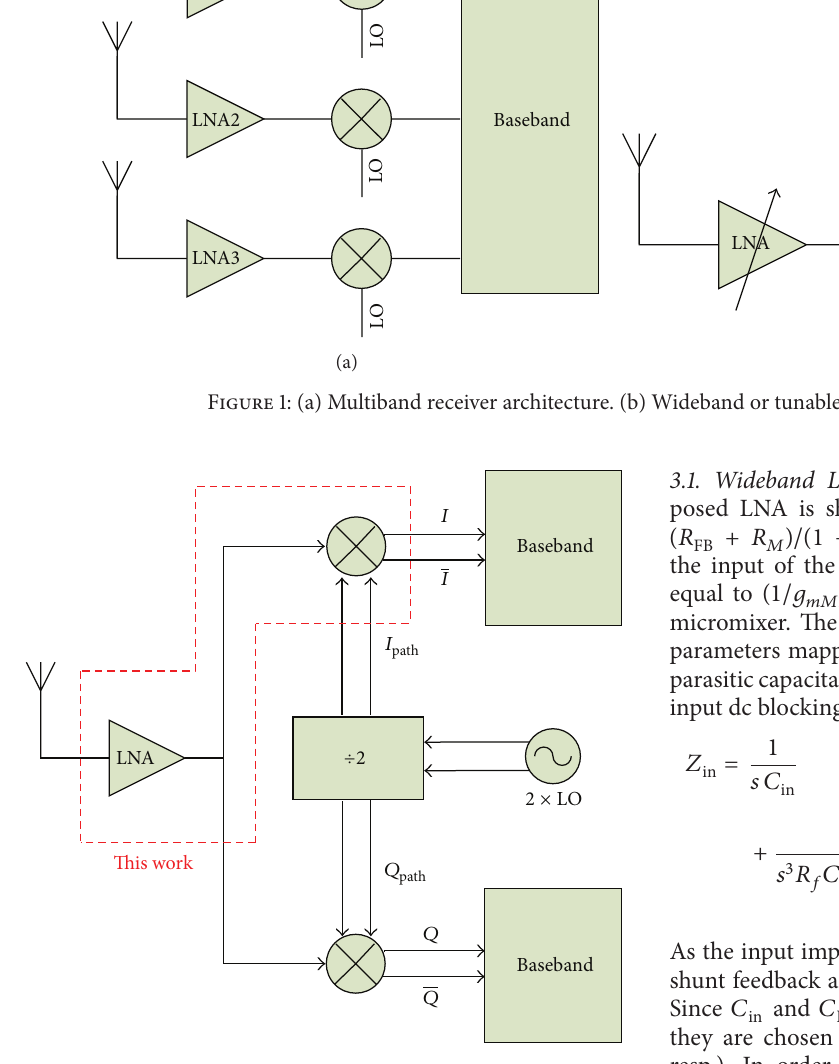
Figure 2: Block diagram of SDR